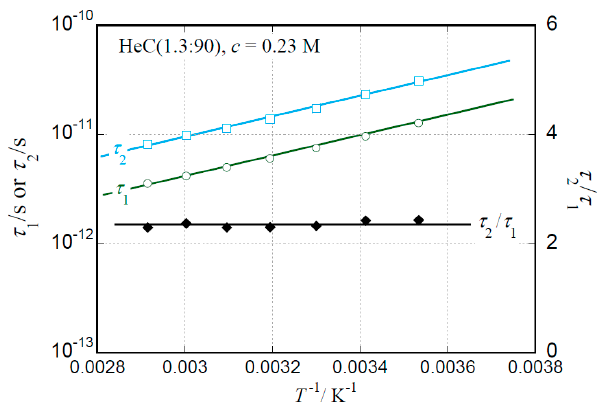
Figure 4. Temperature dependence of dielectric relaxation times, τ 1 and τ 2 , and the retardation ratio, τ 2 / τ 1 , for aqueous solution of HeC(1.3:90) at c = 0.23 M.